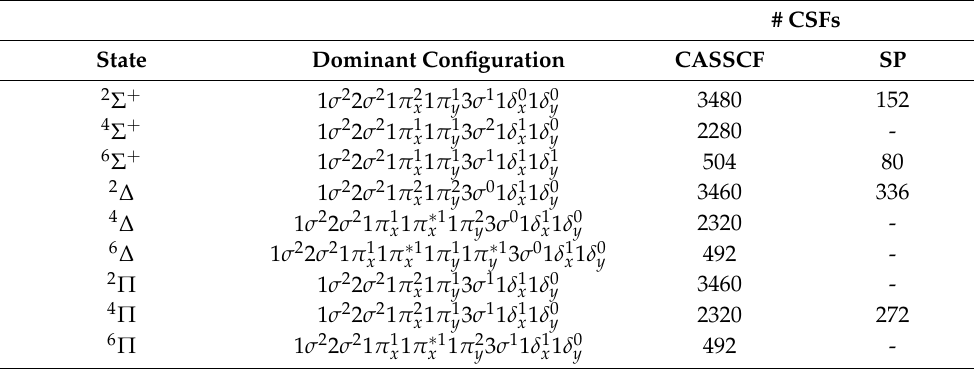
Table 1. The dominant configuration and the number of configuration state functions for the active spaces of each state.